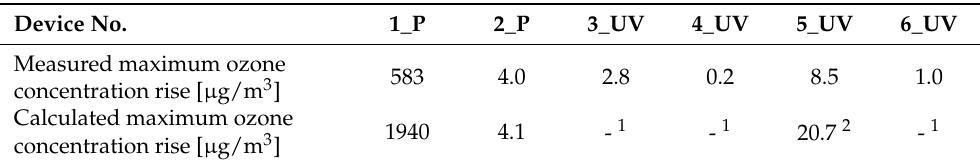
Table 4. Ozone releases during operation. The ozone concentration when the air cleaner was switched on was subtracted from the maximum